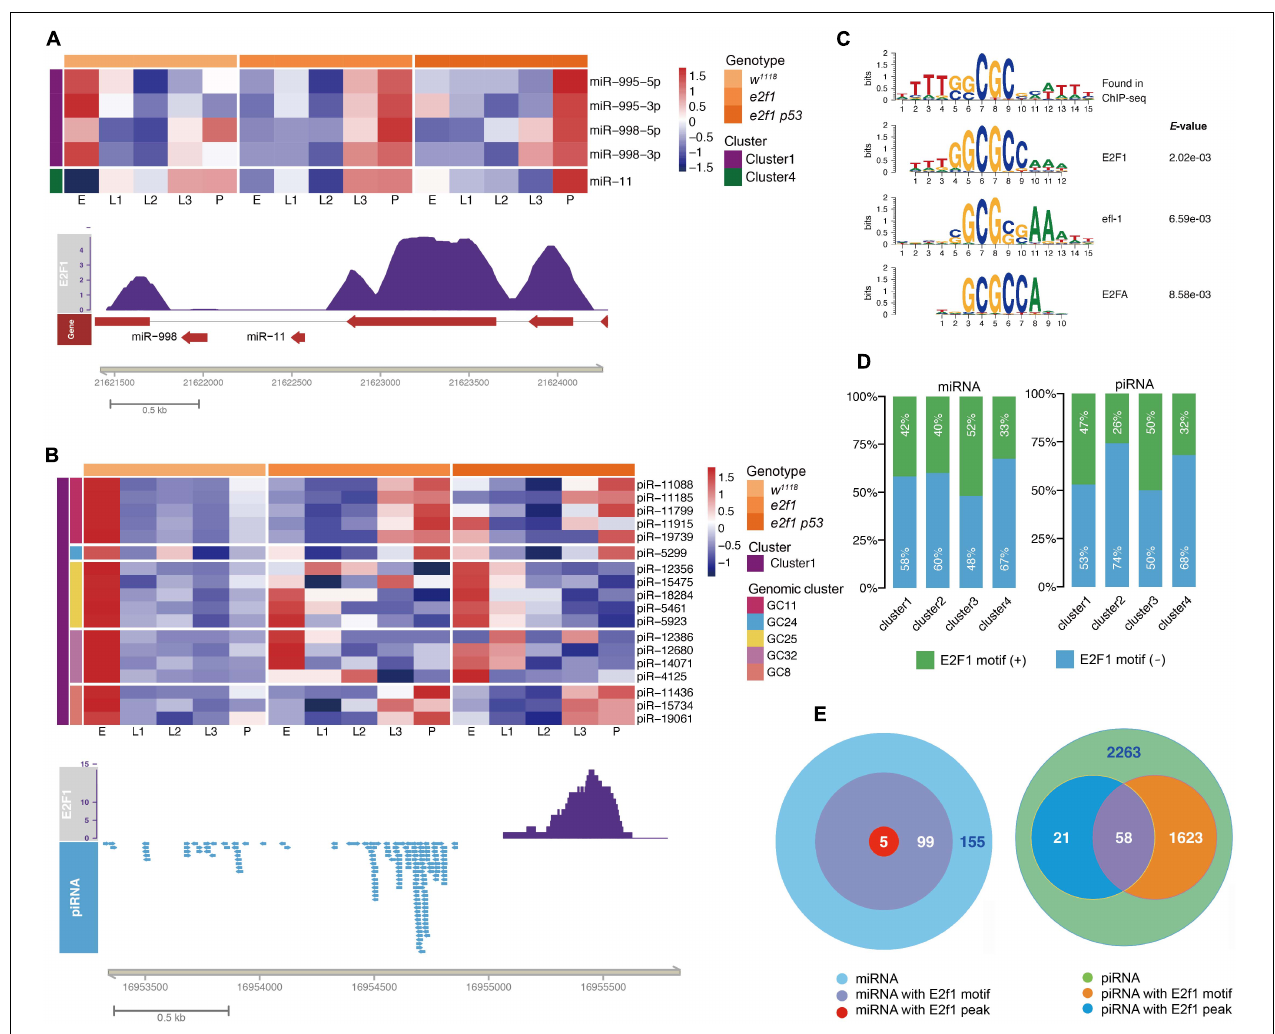
FIGURE 3 | E2f1 regulated small ncRNAs during development. Illustrations of miRNAs (A) and piRNA (B) with E2f1 binding-peak. (C) E2f1 consensus motif derived from MEME de novo motif analysis. (D) Proportion of miRNAs or piRNAs in 4 clusters containing E2f1 binding-motif. (E) Venn diagram showing the overlap of E2f1 binding-peak and E2f1 binding-motif around miRNAs or piRNAs gene